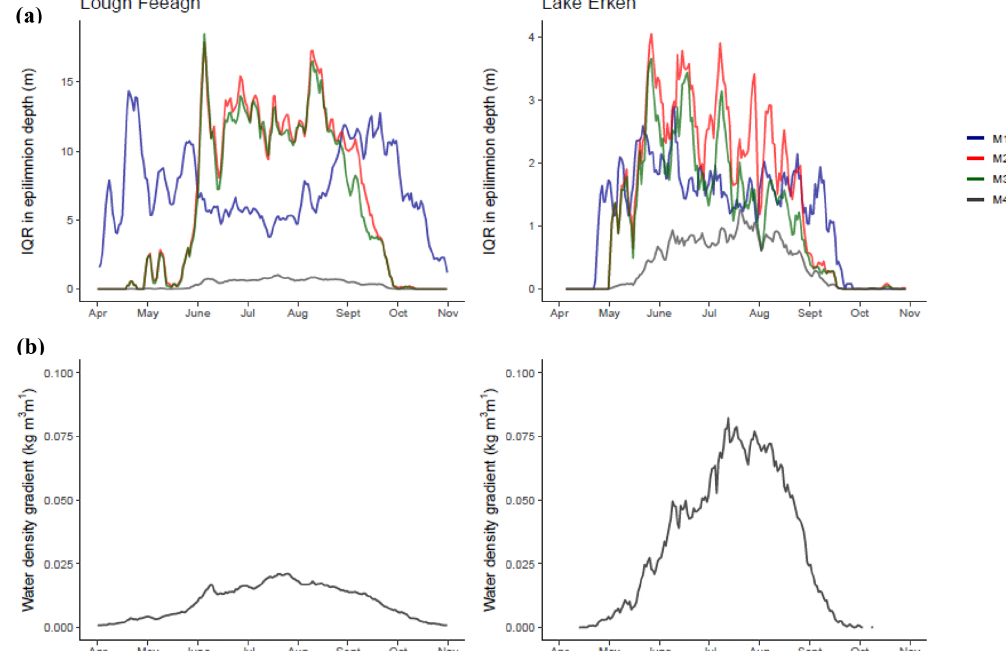
Figure 7. Interquartile range between the shallowest and deepest estimate for each method calculated from long-term daily mean epilimnion depth estimates for each Julian day, when a wide range suggests high threshold sensitivity and a narrow range suggests low sensitivity (a) ; long-term daily mean water density gradient, calculated based on the surface and maximum measured depths (b) for Lough Feeagh and Erken